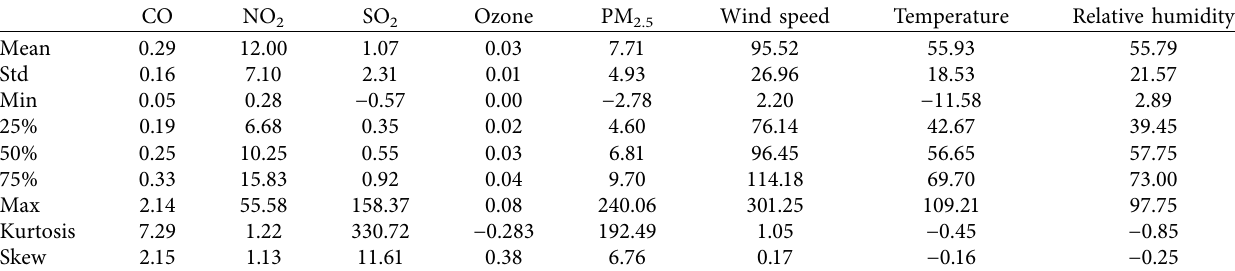
Table 3: Dataset descriptive statistics.